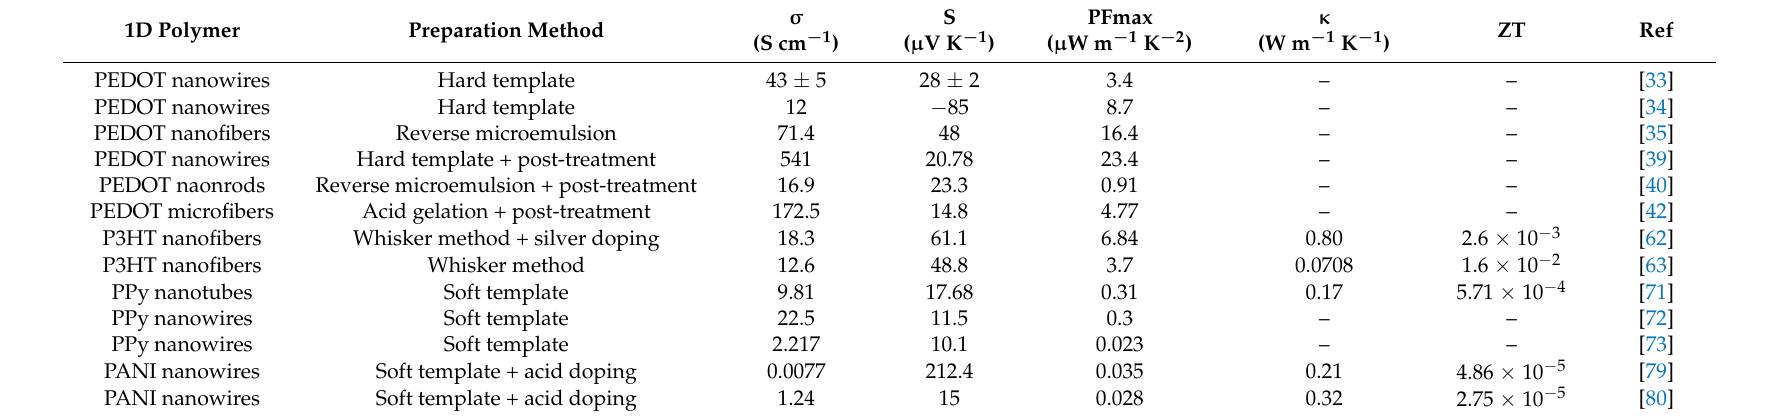
Table 1. Summary of the thermoelectric properties of 1D structured conducting polymers.